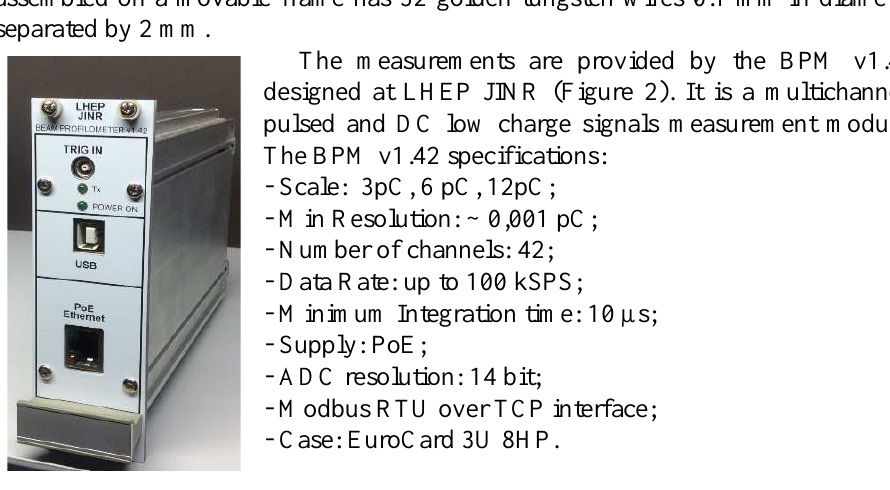
Figure 2. The BPM